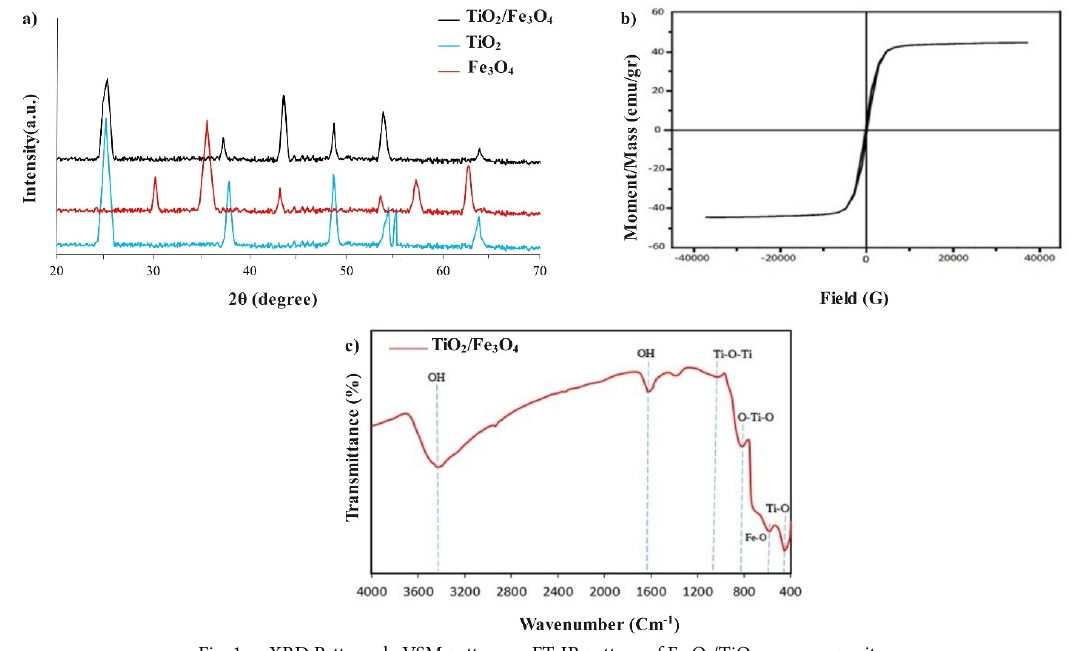
Fig. 1. a. XRD Patterns b. VSM pattern, c. FT-IR pattern of Fe